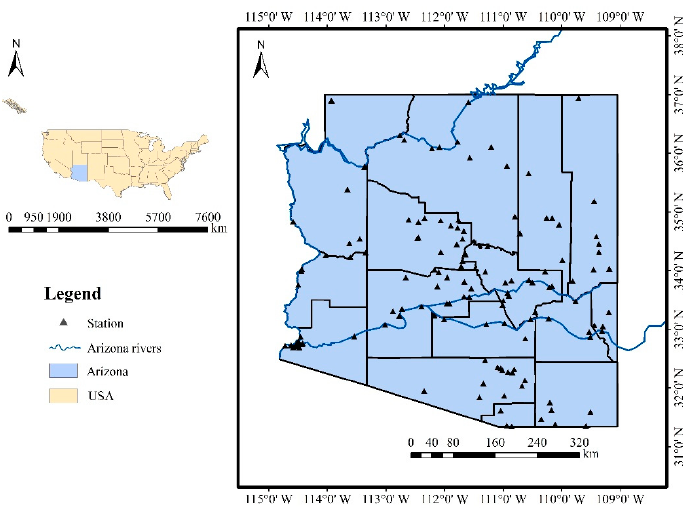
Figure 1. Map of the study area.